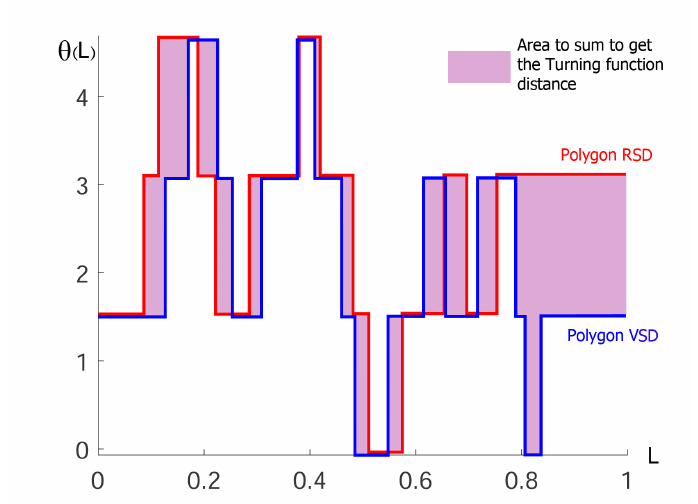
Figure 7. Histogram matching on RSD and VSD